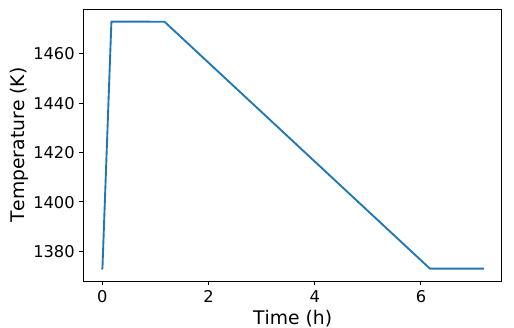
Figure 2. Anisothermal cycle called the “1473–1373 cycle” in simulations using DICTRA: stay at 1473 K for 1 h after a short heating ramp from 1373 K, slow cooling down to 1373 K for 5 h, and final stay at 1373 K for 1